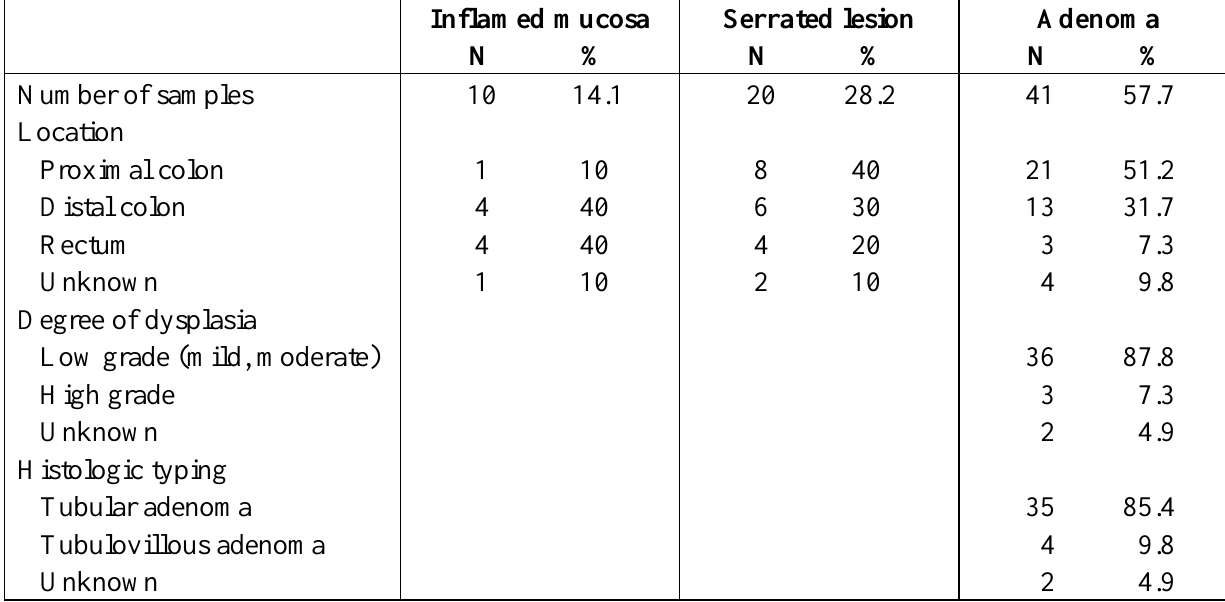
Table 1. Clinicopathologic data of the colorectal lesions